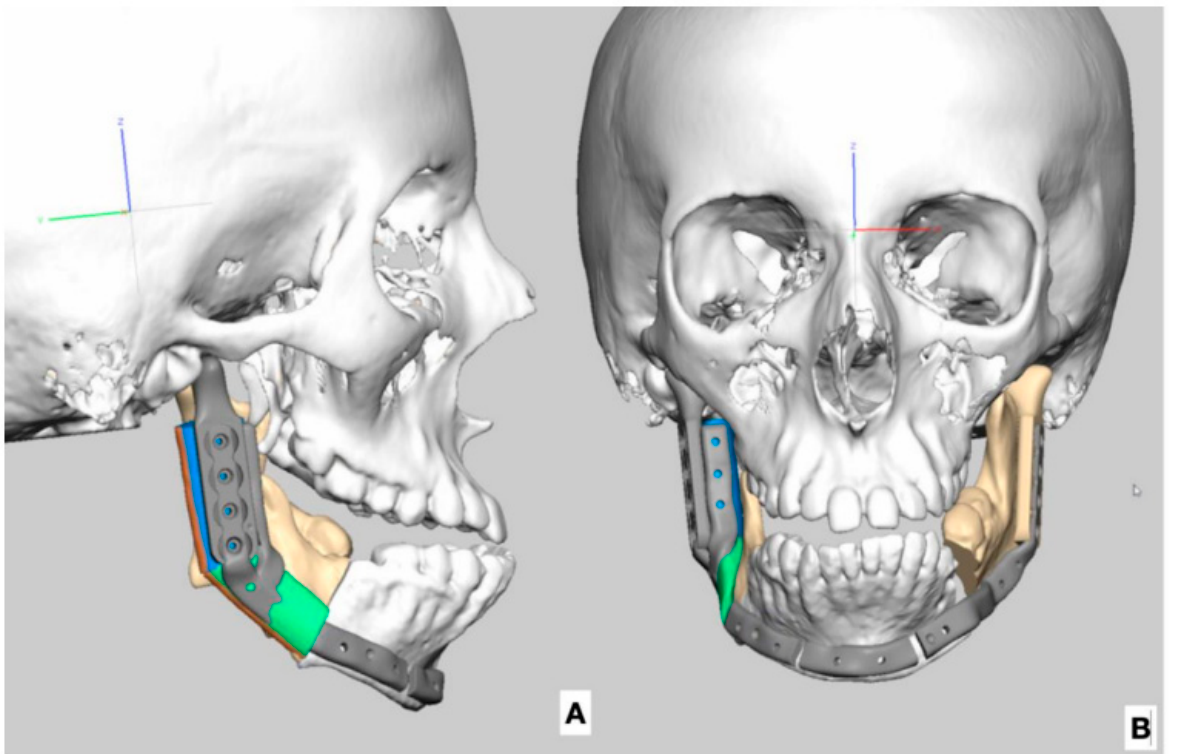
Figure 5. 3D image reconstruction. ( A ) Plan of FFF mandibular ramus reconstruction in combination with TMJ alloplastic prosthesis. ( B ) Frontal view of the plan of FFF mandibular ramus reconstruction, planned additional mandibular osteotomy on the left side.